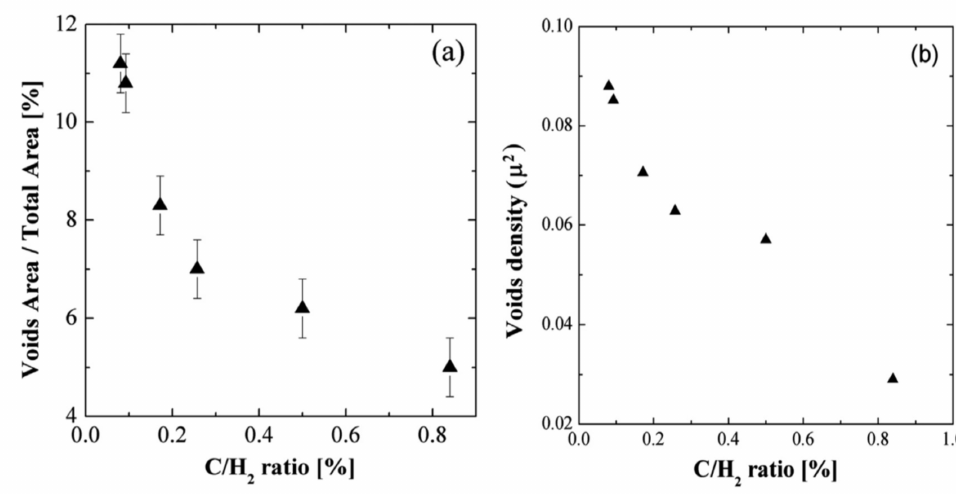
Figure 10. The percentage of void areas occupied with respect to the total observed area ( a ) and voids’ density ( b ) are reported as a function of the C/H 2 ratio [%] (see Reference